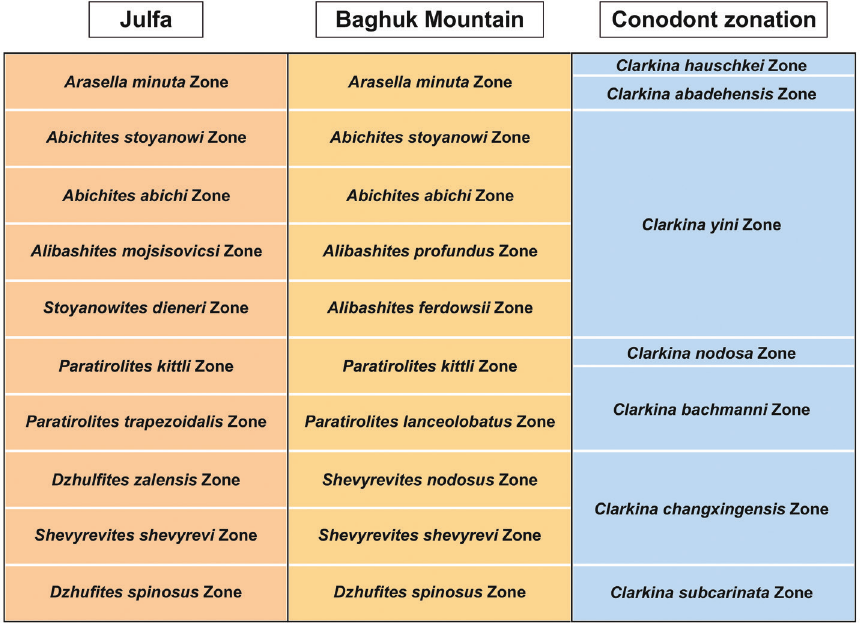
Fig. 10. Correlation of the ammonoid zonations of the Julfa region in NW Iran (after Korn et al. 2016) and Baghuk Mountain with the conodont stratigraphy (after Farshid et